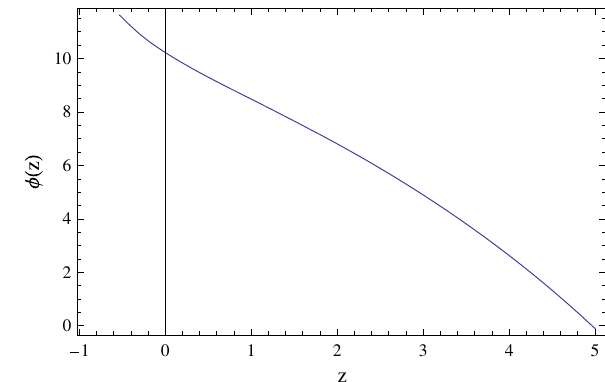
Fig. 26 Variation of H ( z ) with the variation of z (Model IV) by con- sidering the best fit values w 0 = − 0 . 766 ,w 1 = 0 . 307